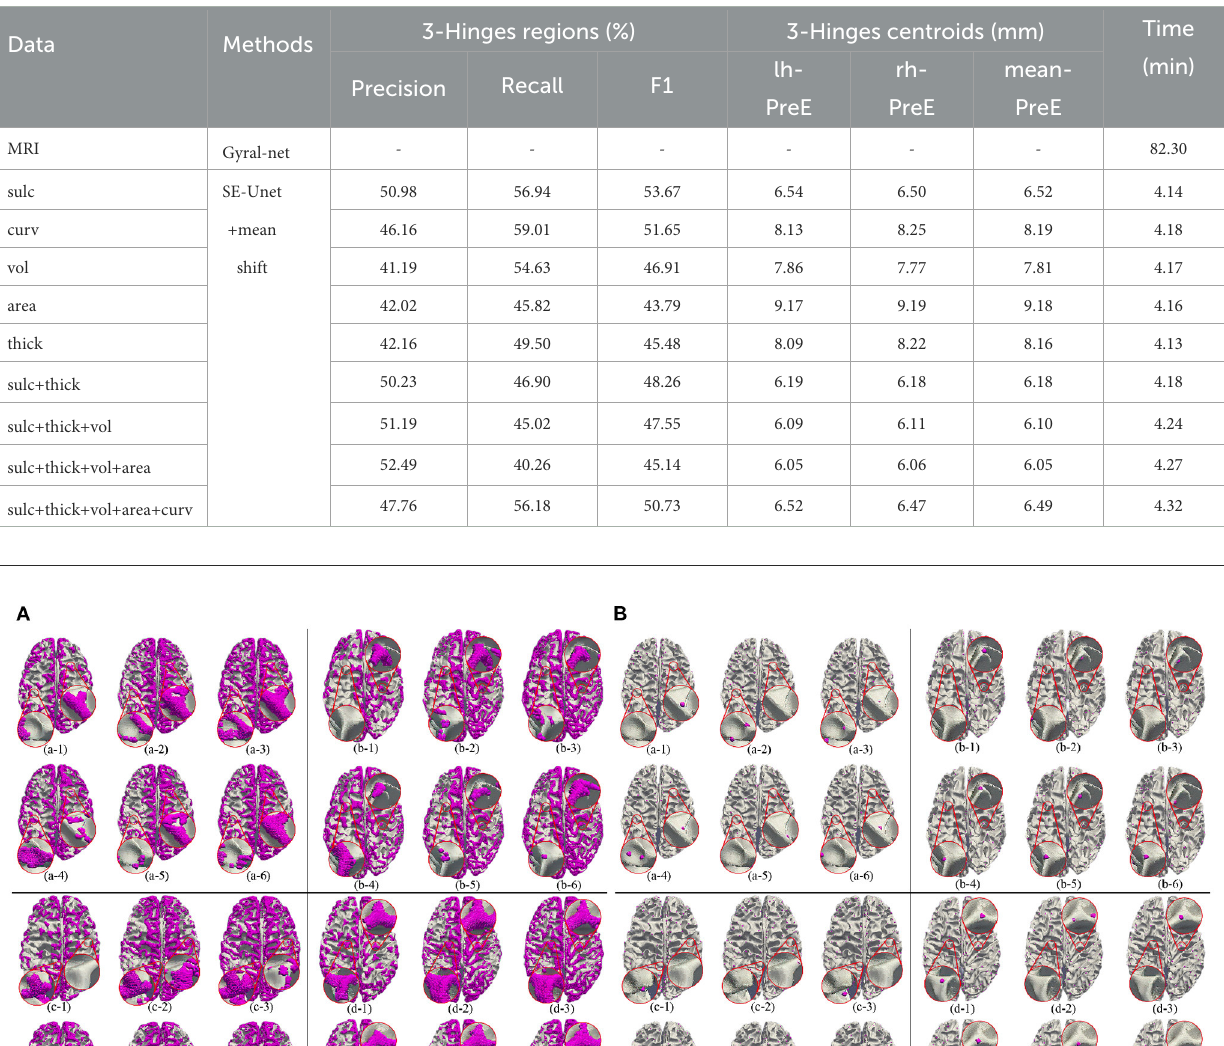
TABLE 5 The identification results of HCP data set.